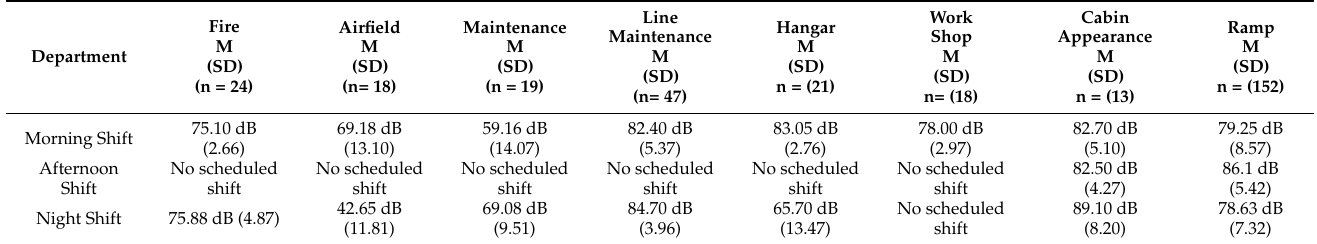
Table 1. Average noise exposure level (L TWA ) measured in dB for airport departments by shift.